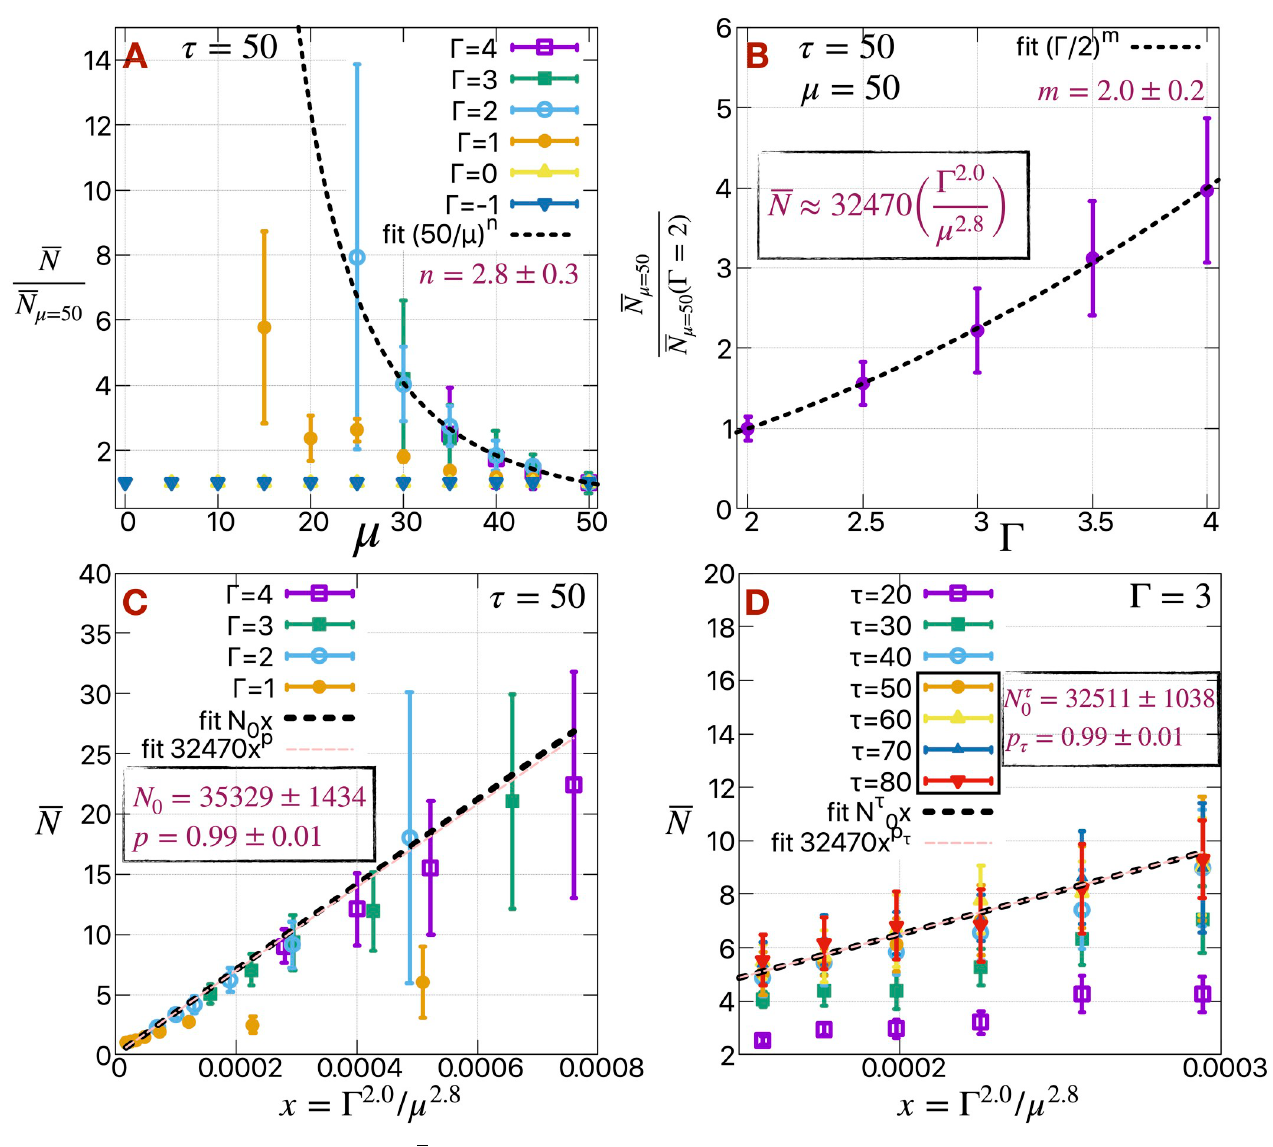
Fig 3. Scaling behavior of mean cluster size. (A) N as a function of μ representing the collapse of all the data shown in Fig 2A into a master curve for Γ > 1. N m ¼ 50 (B) N m ¼ 50 as a function of Γ . (C) N as a function of x = Γ 2.0 / μ 2.8 . (D) N as a function of x = Γ 2.0 / μ 2.8 for different values of persistence time of cell polarity ( τ ). N m ¼ 50 ð G ¼ 2 Þ The details underlying the fitting of these data are described in the main